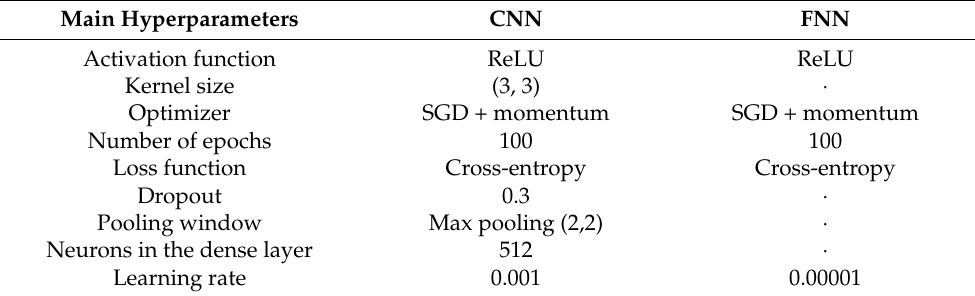
Table 2. The main parameters of each